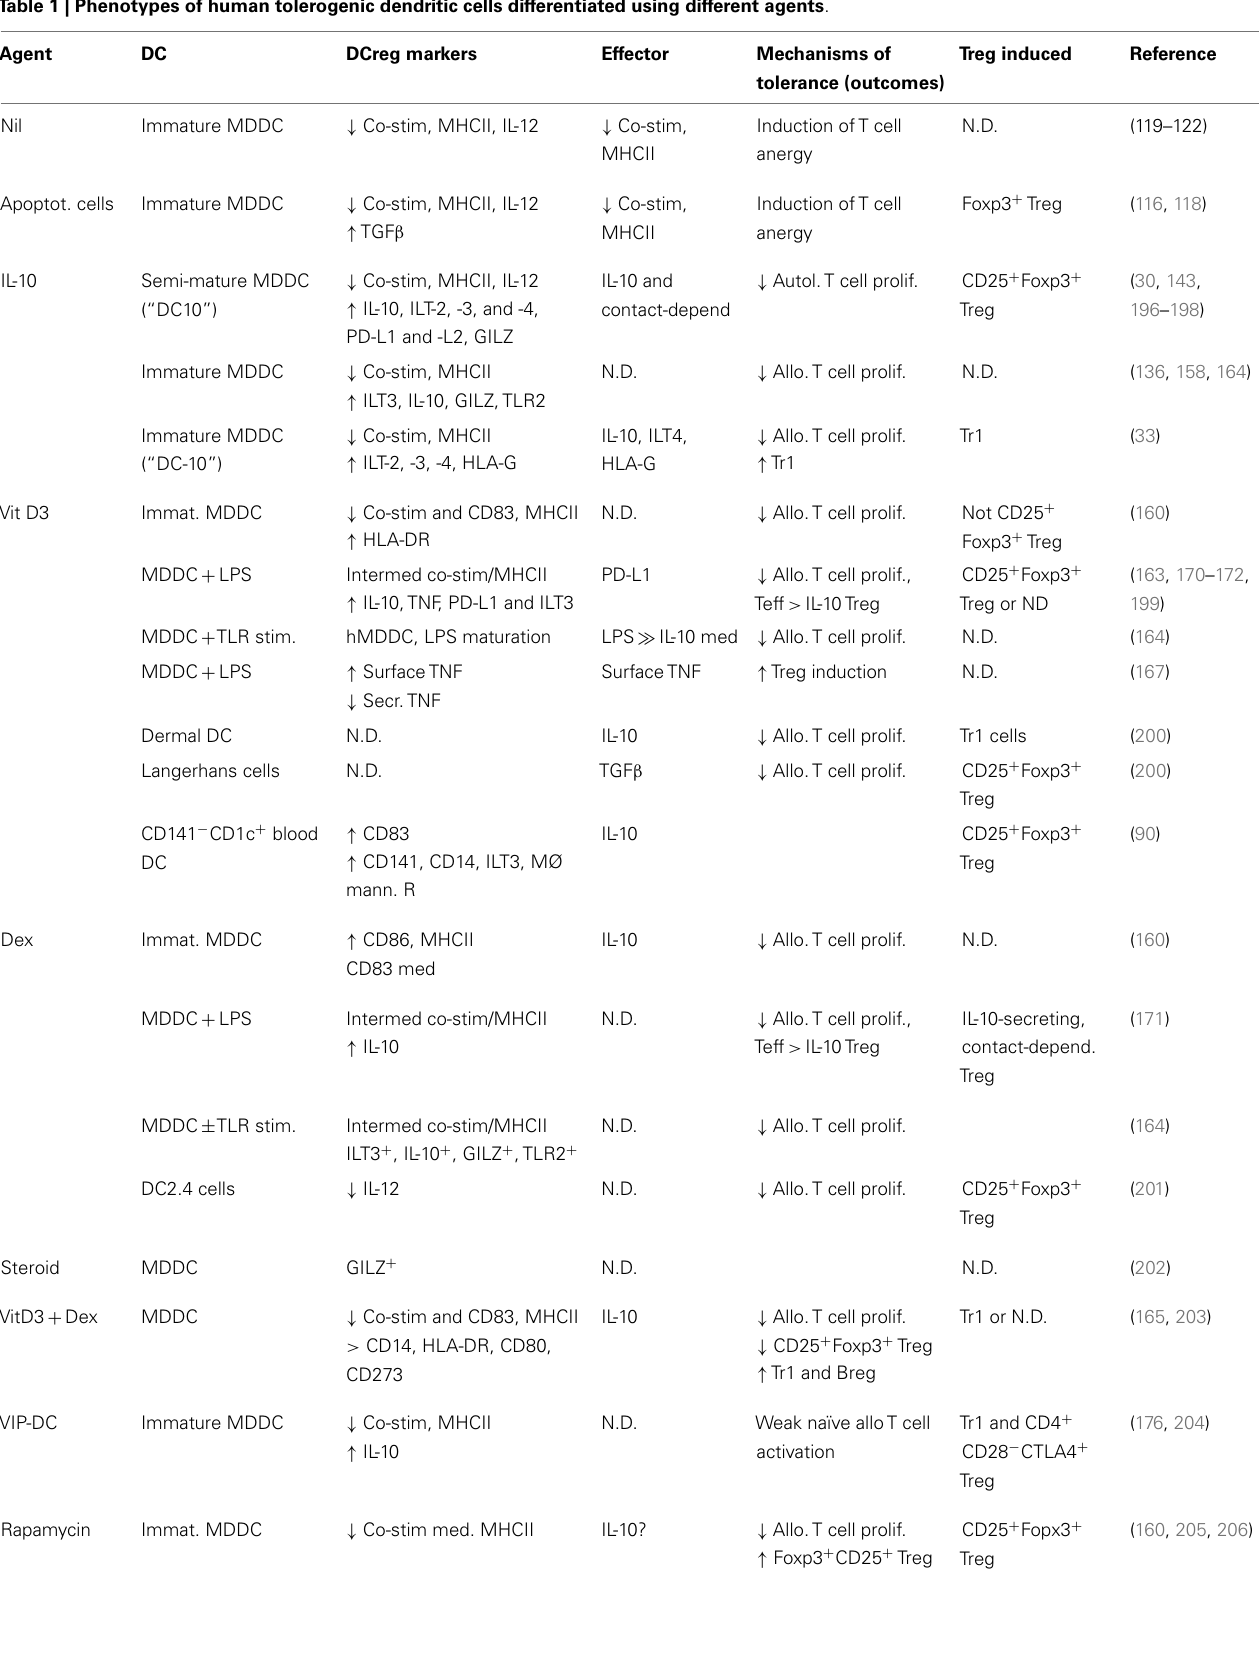
Table 1 | Phenotypes of human tolerogenic dendritic cells differentiated using different agents .